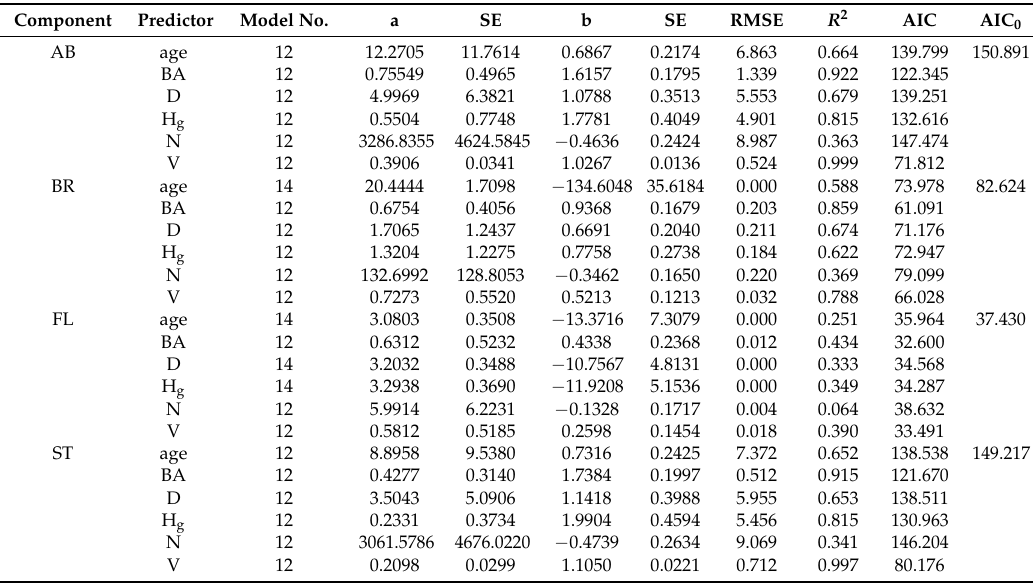
Table 4. Relationships between forest stand characteristics (predictors) and forest stand biomass components (Mg ha − 1